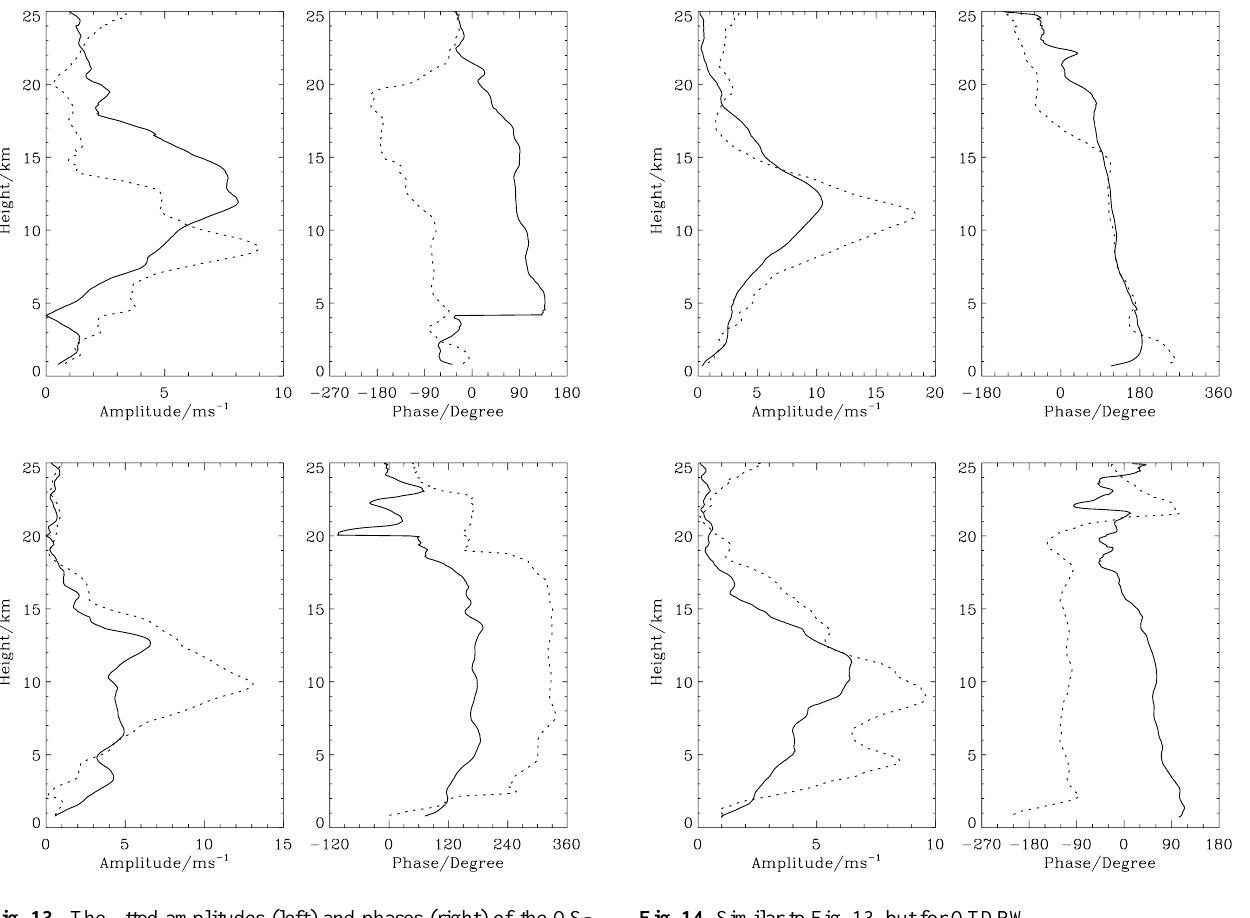
Fig. 13. The fitted amplitudes (left) and phases (right) of the QS- DPW in August 2006 (solid) and January 2007 (dotted) in zonal wind (upper) and meridional wind (lower).